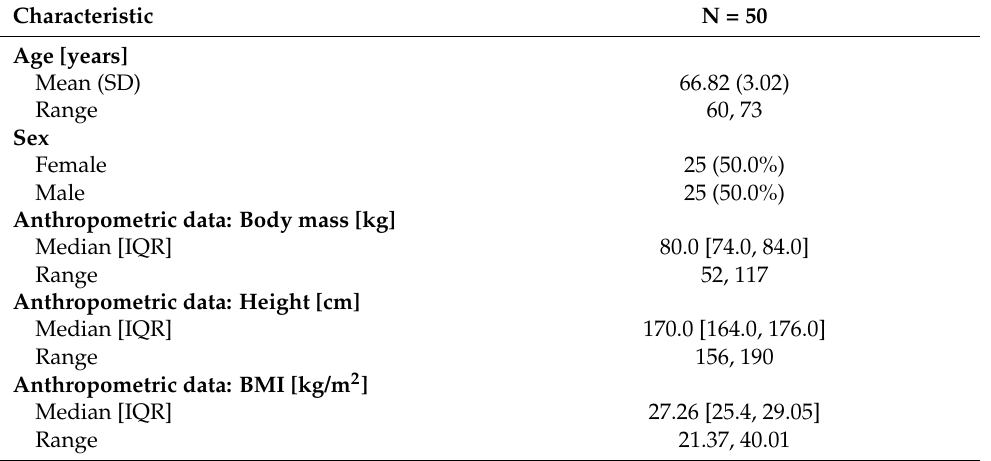
Table 1. Demographic characteristics.